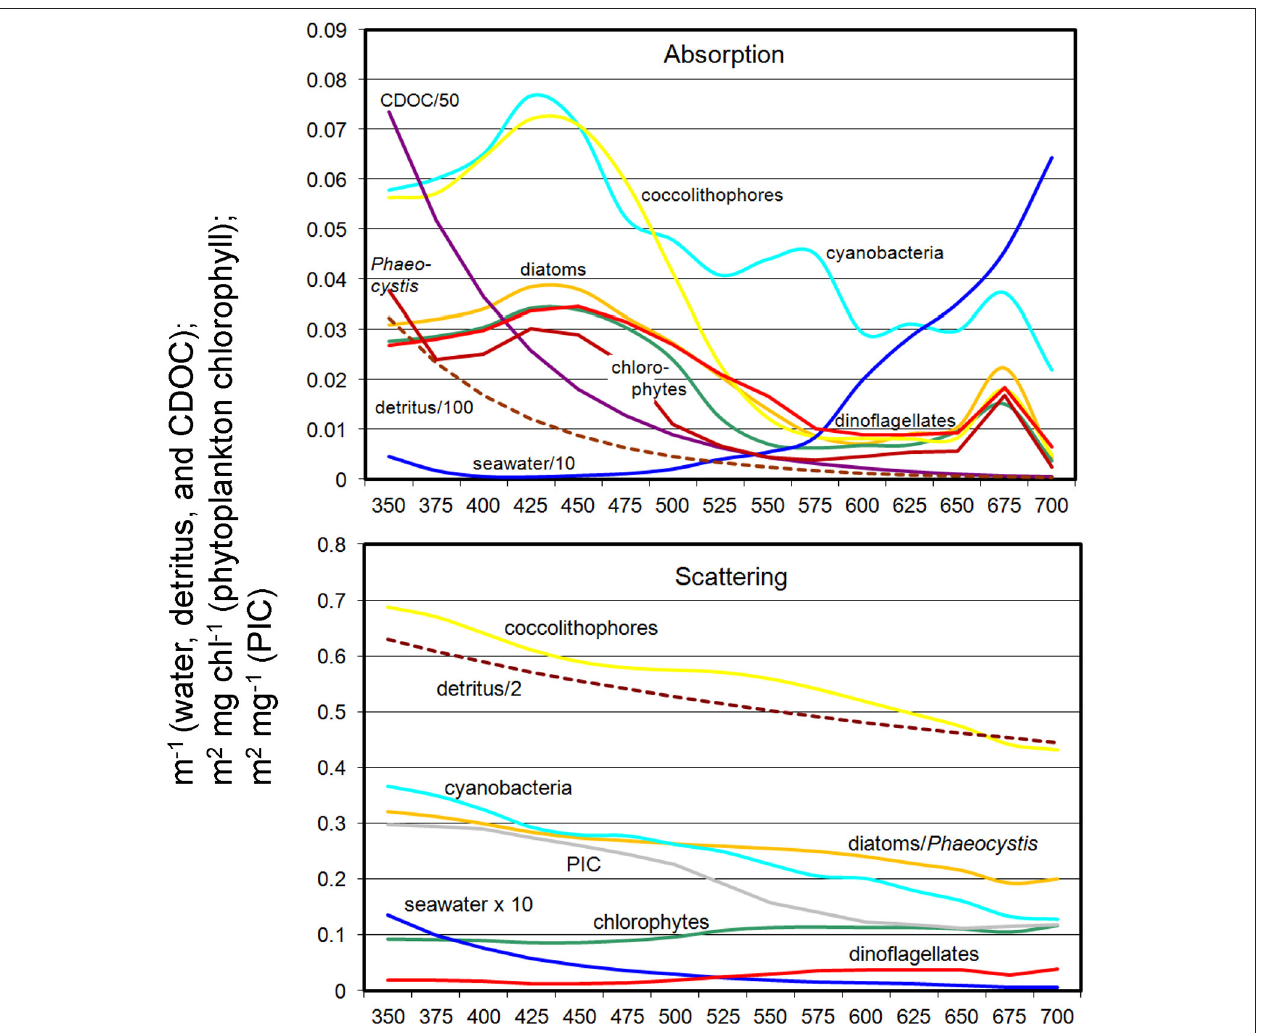
FIGURE 3 | Spectral absorption and scattering coefficients of water, phytoplankton, detritus, PIC, and CDOC in